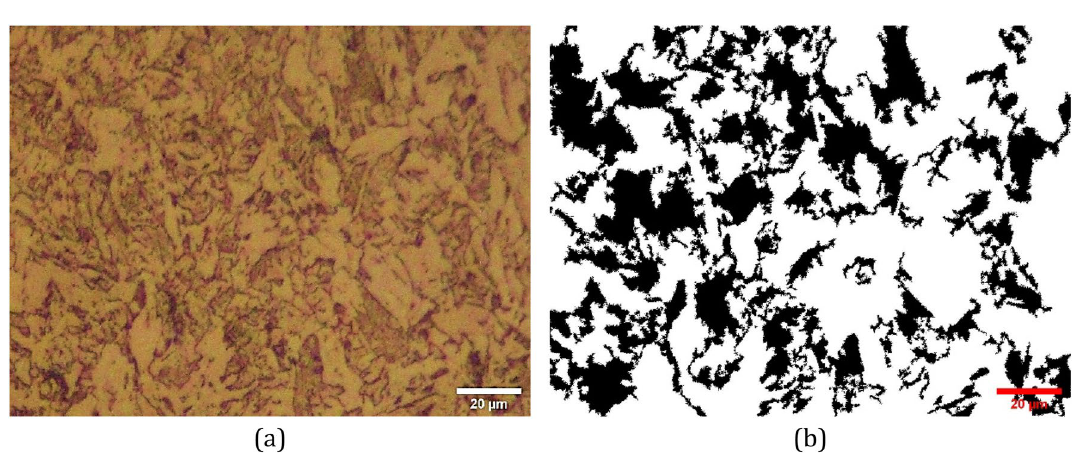
Figure 2. Microstructure of 316 L sheet after being rolled to 50% thickness reduction as viewed from normal to sheet plane direction, 200x, acetic